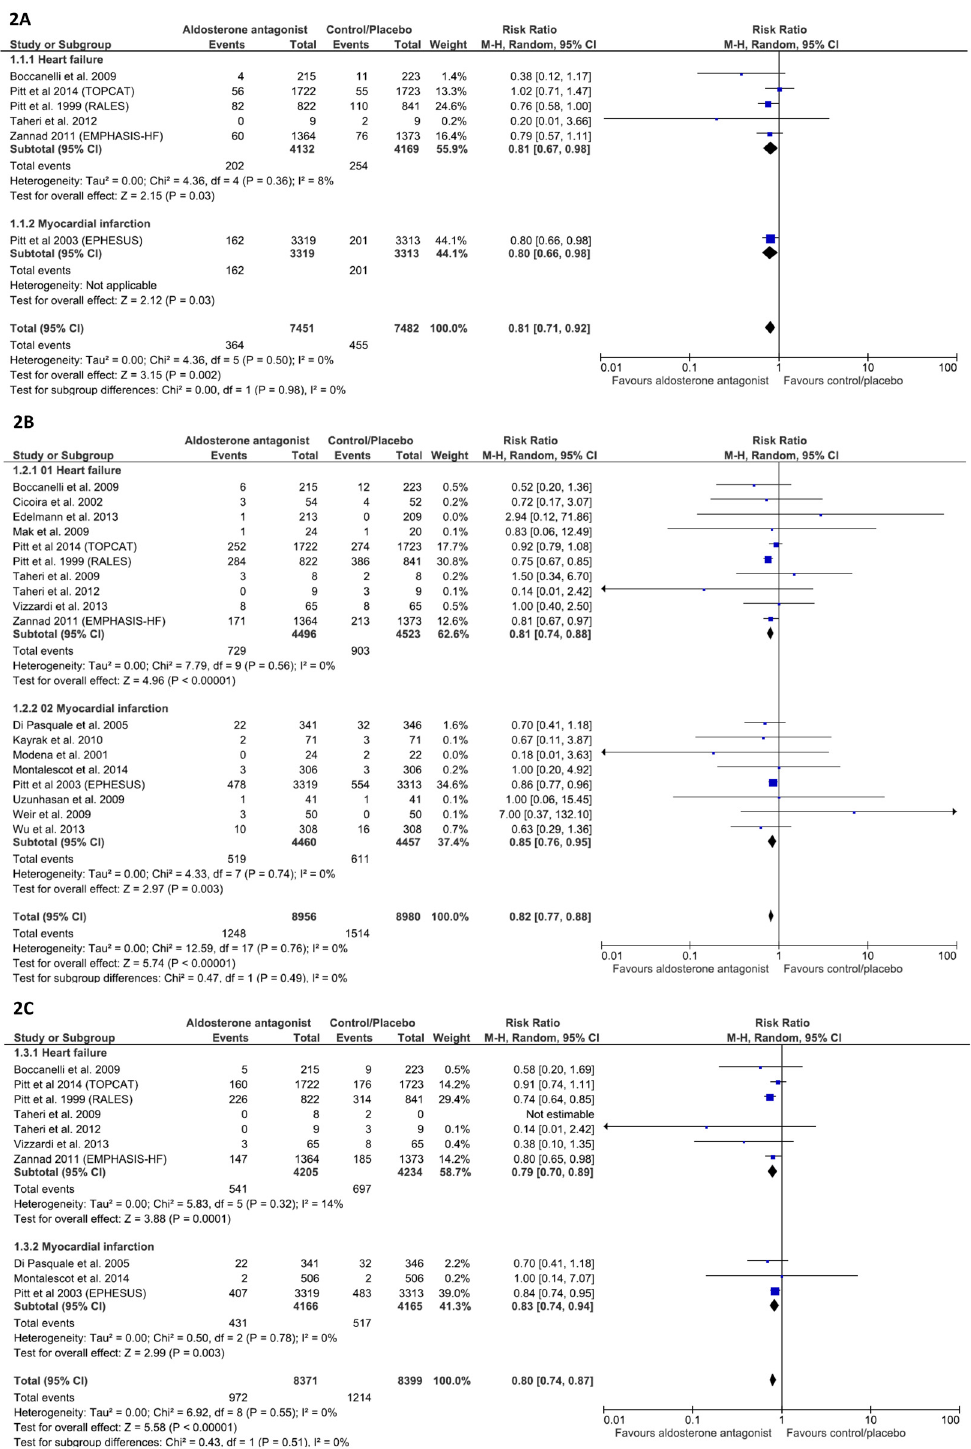
Fig 2. Efficacy of aldosterone antagonist compared with control for the prevention of (A) Sudden death, (B) All-cause mortality, and (C) Cardiovascular death in patients with heart failure or myocardial infarction.